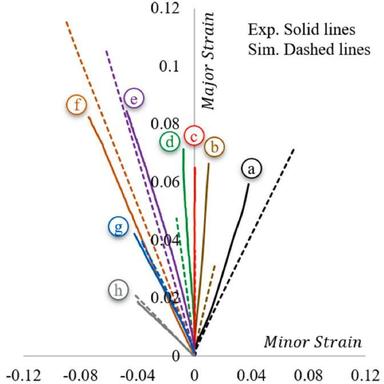
Comparison of the controlled strain paths by FEM + PID using von Mises yield function and the measured ones for different deformation paths.